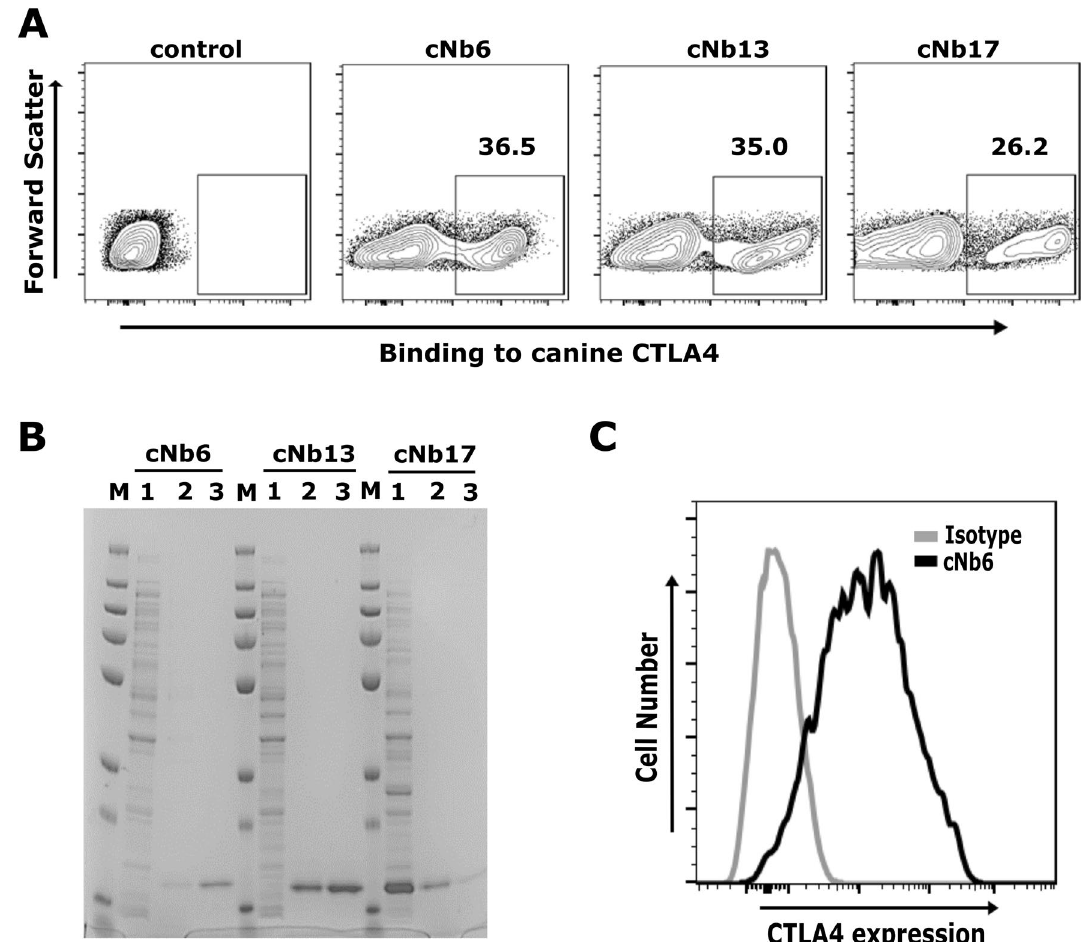
Figure 1. Discovery of nanobodies targeting canine CTLA4. ( A ) Single yeast clones bind to canine CTLA4. After three rounds of MACS selection, the enriched yeast nanobody library was sorted by FACS to obtain single yeast clones. Single yeast clones were induced with galactose to express nanobody on their cell surface and labeled with 100 nM of AF647-labeled canine CTLA4 protein. Three yeast clones (cNb6, cNb13 and cNb17) showed excellent binding to AF647-labeled canine CTLA4 protein. Noninduced yeast cells (cNb6) do not bind to AF647-labeled canine CTLA4 protein. ( B ) Purity of nanobodies assessed by SDS-PAGE. DNA sequences coding cNb6, cNb13 and cNb17 were amplified and cloned into a pET22b vector. Nbs were expressed and purified in E. coli BL21 (DE3) cells by affinity (StrepTrap) and size-exclusion chromatography (Superdex 10/300 GL). Purified nanobodies were resolved on SDS-PAGE gel and stained with GelCode Blue Stain Reagent. M— protein ladder, 1—unpurified protein, 2 and 3—1st and 2nd elute of purified Nbs. ( C ) Binding of cNb6 to cells expressing canine CTLA4 demonstrated by flow cytometry. MDCK cells transiently expressing CTLA4 were stained with cNb6, washed, and bound cNb6 was detected with anti-His-647 by flow cytometry. A non-specific Nb was used as an isotype